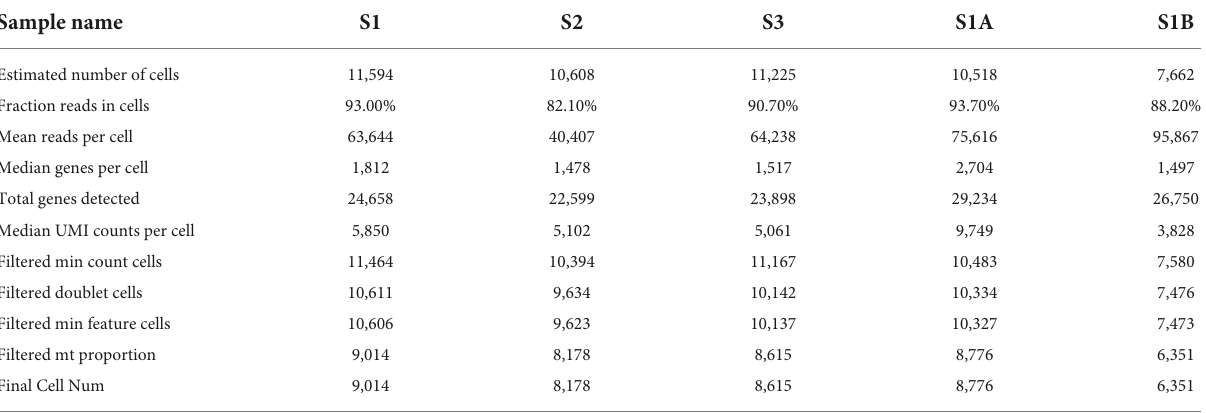
TABLE 2 Statistical tables of sample cells and gene